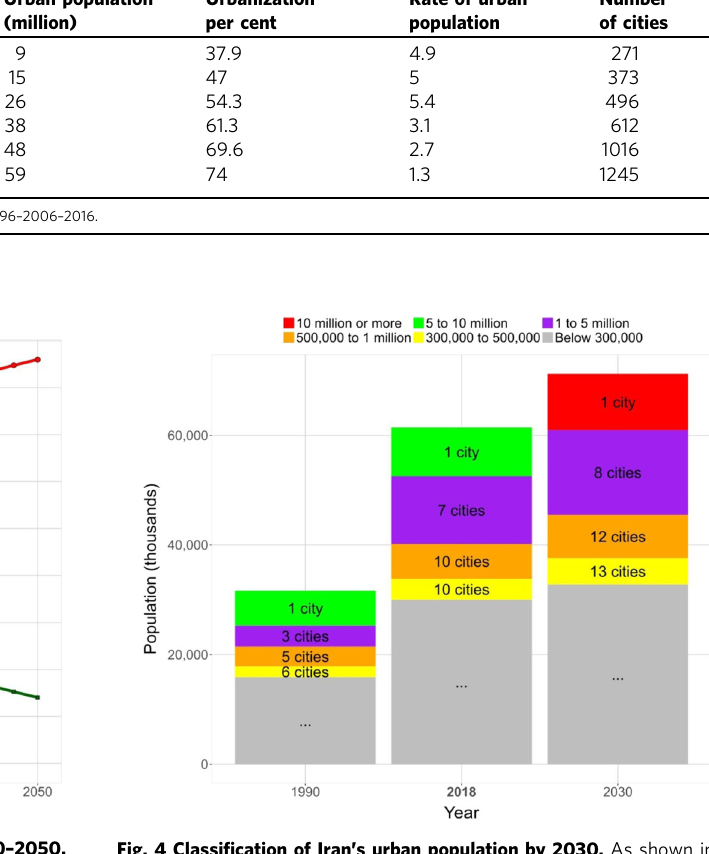
Fig. 4 Classi fi cation of Iran ’ s urban population by 2030. As shown in fi gure, Iran had a city with a population of 10 million in 2018 (Tehran). It is projected that by 2030, the number of cities with up to 5 million populations will increase. Therefore, Iranian cities manifest a rising trend in terms of population and urbanization. Classi fi cation of urban population in terms of the size of urban settlement and the number of cities in 1990, 2018, and 2030. The gray area denotes residual areas, which include all urban settlements with <300,000 populations. Source: United Nations (2018). Department of Economic and Social Affairs, Population Division, and World Urbanization Prospects: The 2018 Revision.